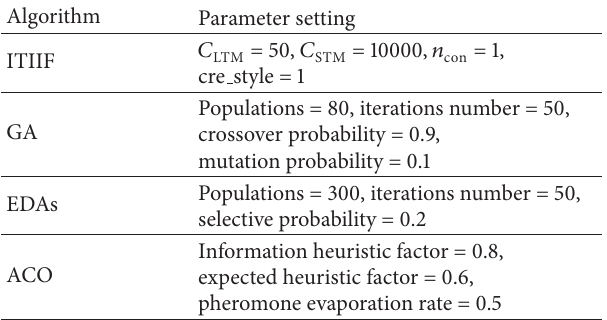
Table 3: The parameters settings of each